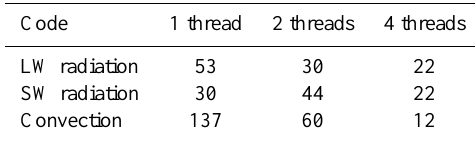
Table 3. Optimal segments sizes for different routines with different numbers of OpenMP